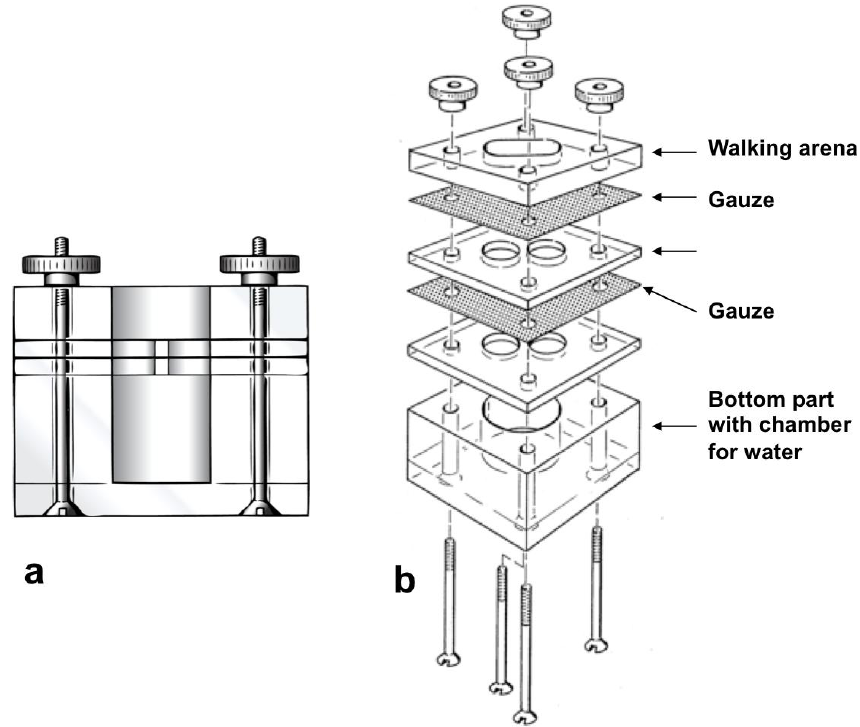
Figure 2. Static two-chamber olfactometer. ( a ) Lateral view. ( b ) Exploded drawing, showing the different